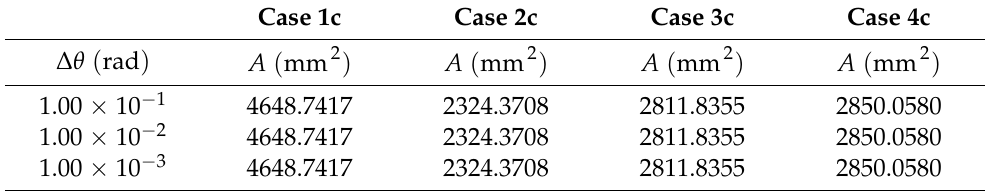
Table 5. Convergence analysis for Equation (15)